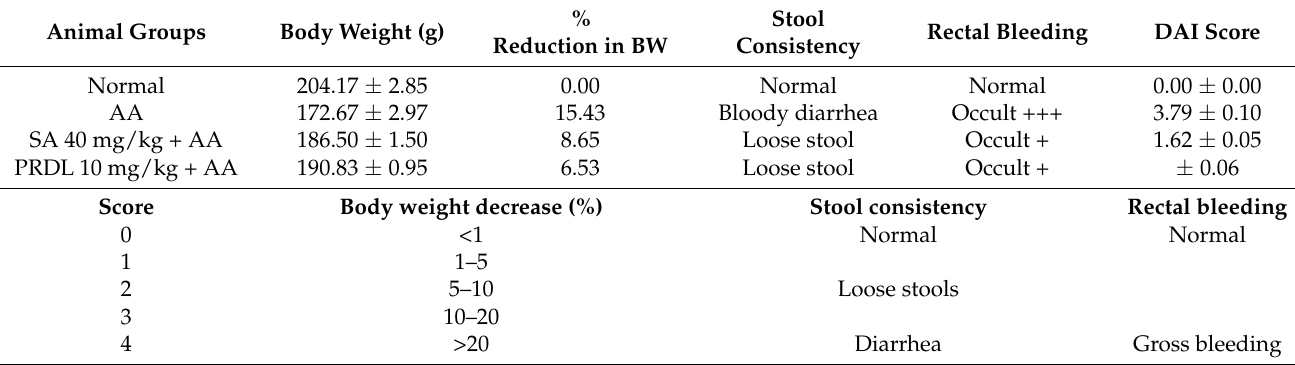
Table 1. Scoring of disease activity